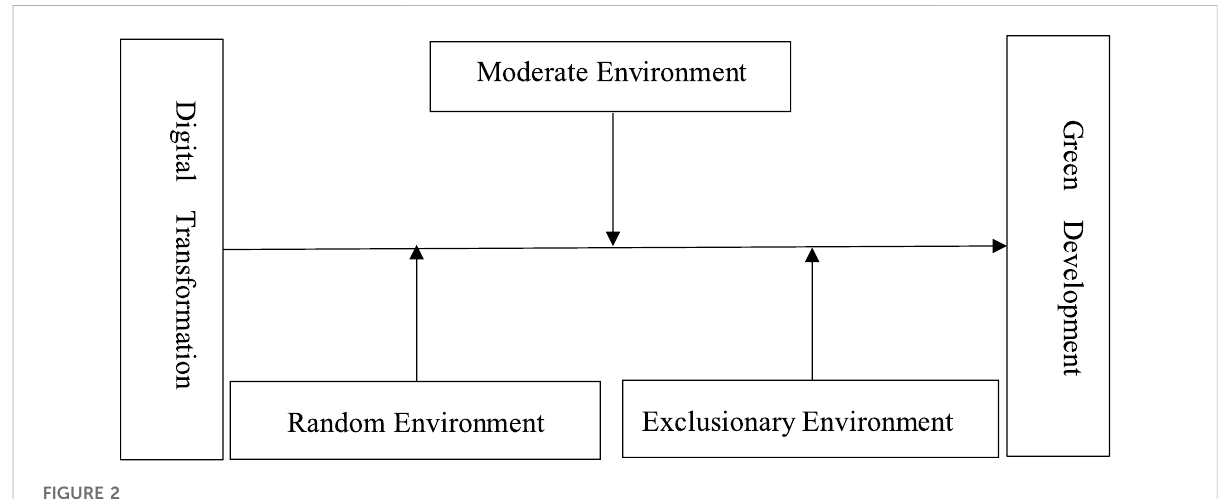
FIGURE 2 The moderating effect of environmental